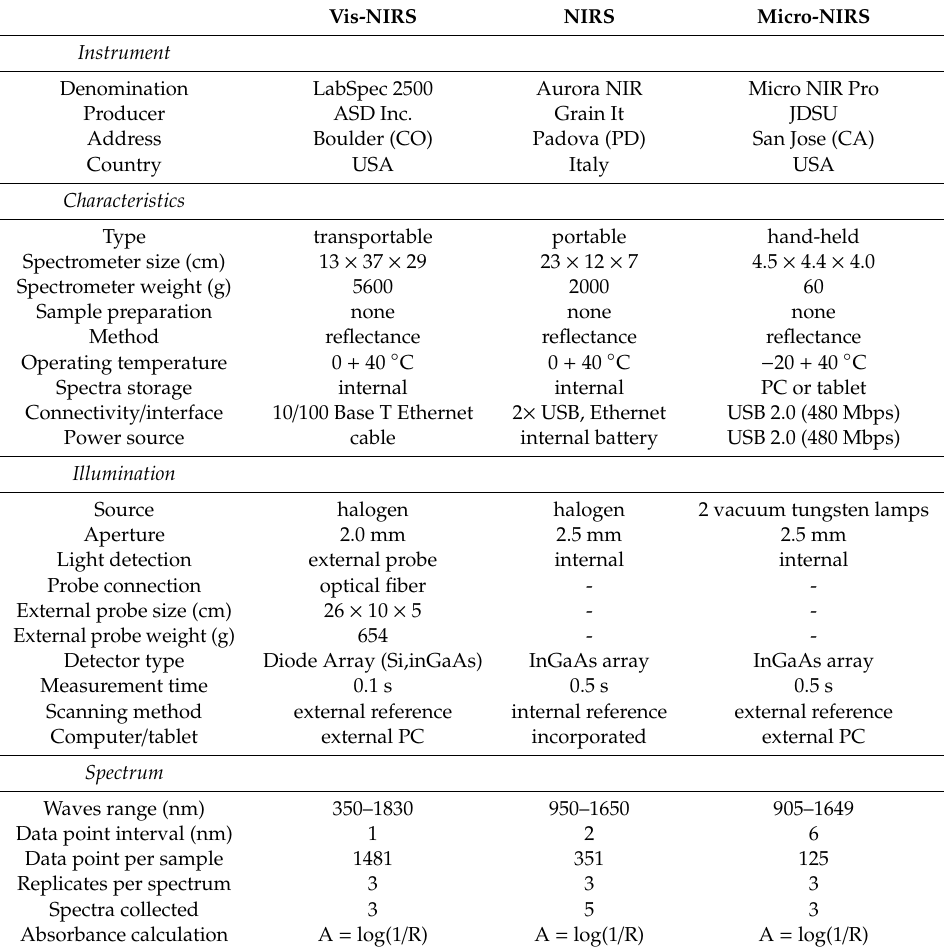
Table 2. Main characteristics of the portable NIR spectrometers used to predict the mineral content of